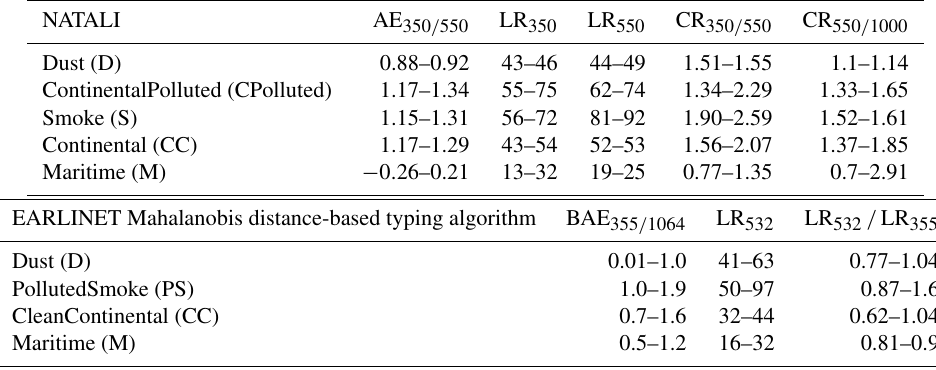
Table 2. Mean aerosol optical properties of the reference aerosol types used on the two automated